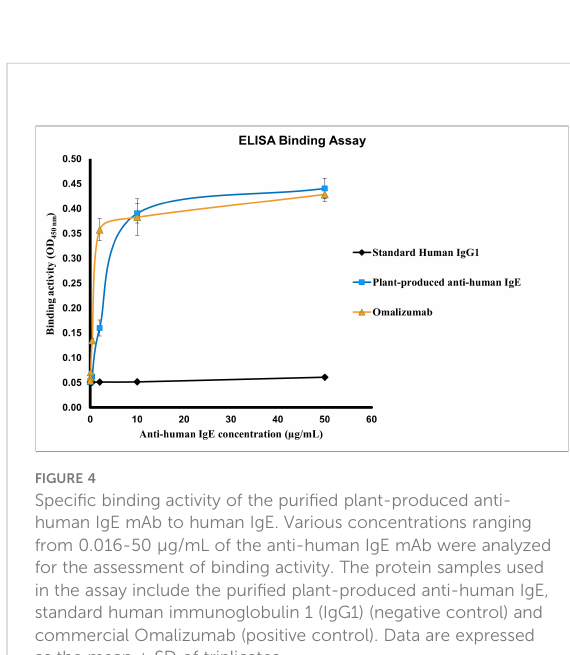
FIGURE 4 Speci fi c binding activity of the puri fi ed plant-produced anti- human IgE mAb to human IgE. Various concentrations ranging from 0.016-50 µg/mL of the anti-human IgE mAb were analyzed for the assessment of binding activity. The protein samples used in the assay include the puri fi ed plant-produced anti-human IgE, standard human immunoglobulin 1 (IgG1) (negative control) and commercial Omalizumab (positive control). Data are expressed as the mean ± SD of triplicates.